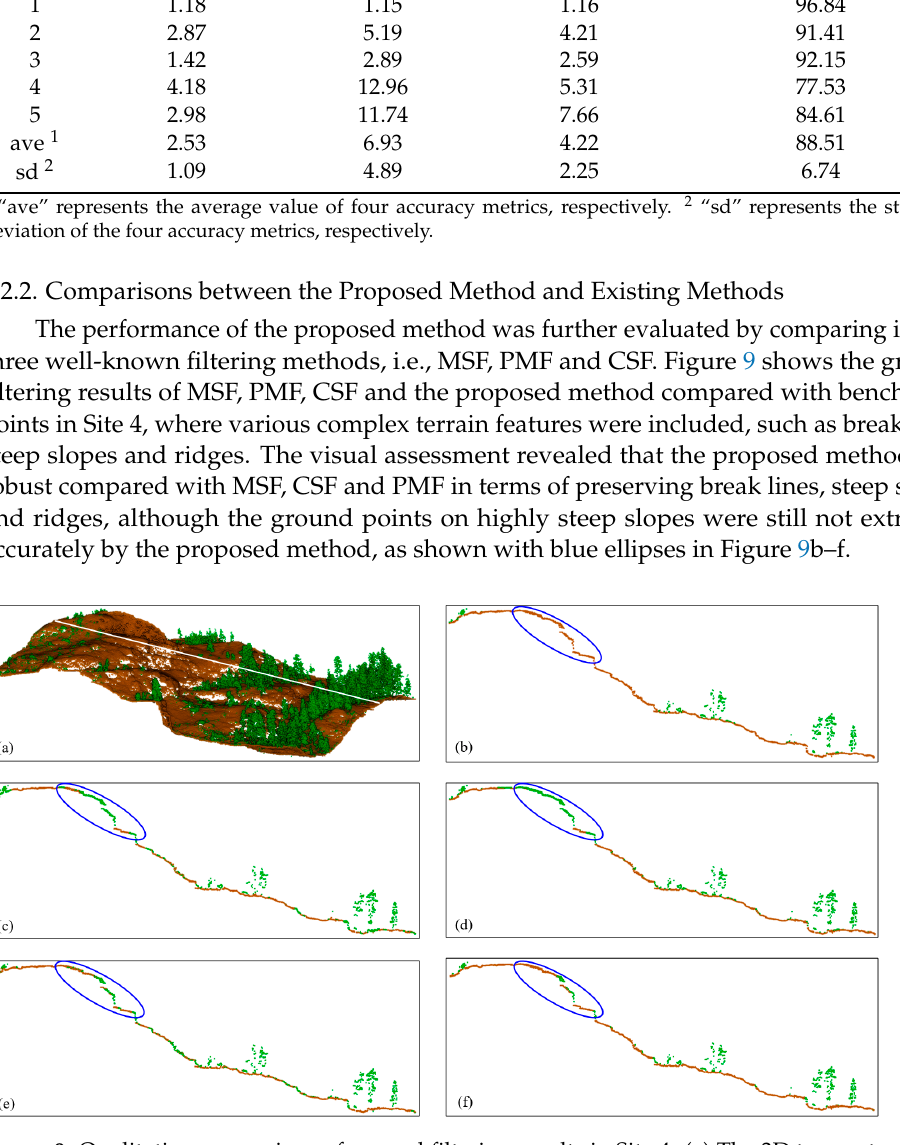
Figure 10. Accuracy assessment of four filtering methods in five forested sites: ( a ) kappa coefficient, ( b ) total error, ( c ) type I error and ( d ) type II error.